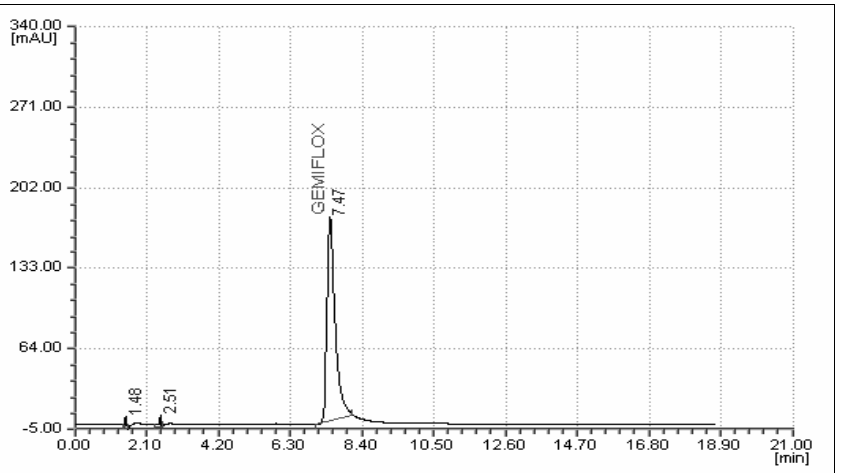
Figure 4. Chromatogram of gemifloxacin mesylate standard